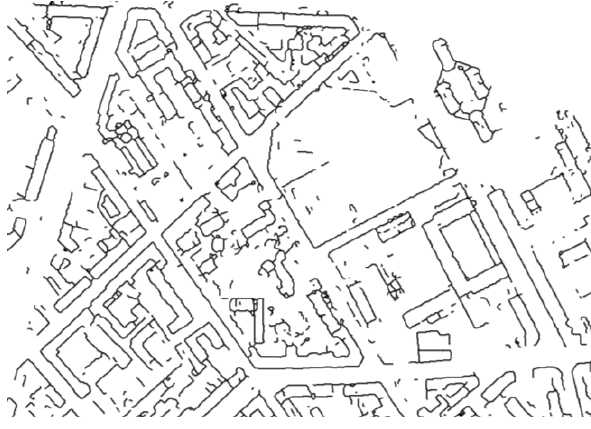
Figure12. Extracted footprints from the second test